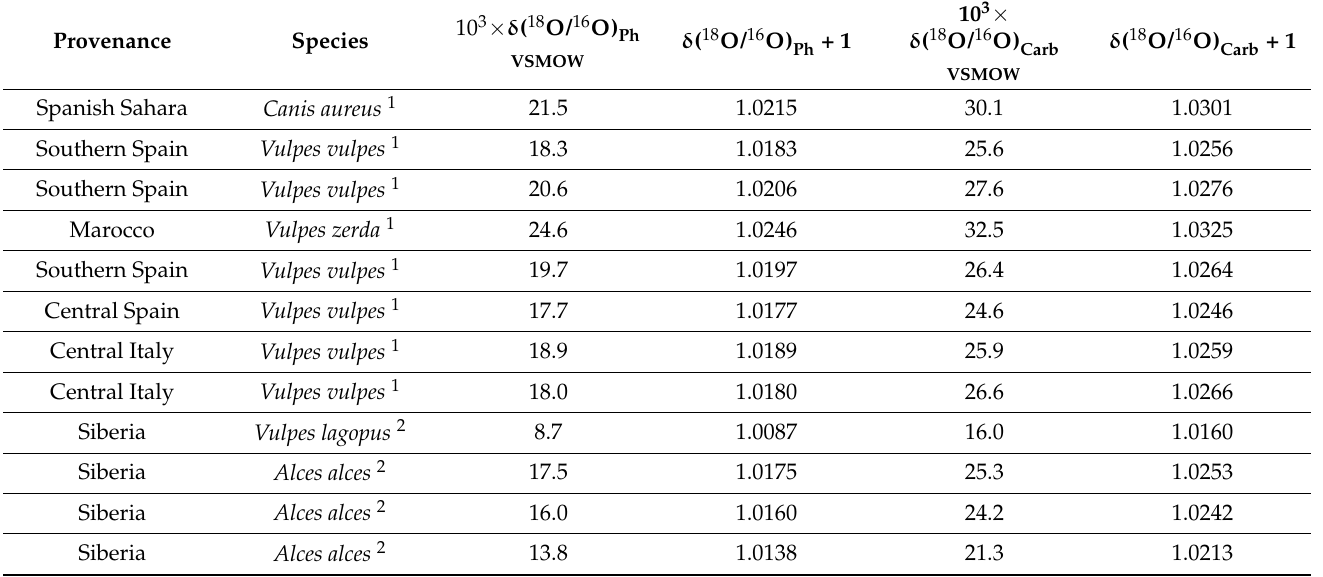
Table 1. Oxygen isotope analyses of phosphate, Ph, and carbonate, Carb, from bone and tooth (enamel) bioapatite of modern mammals of different